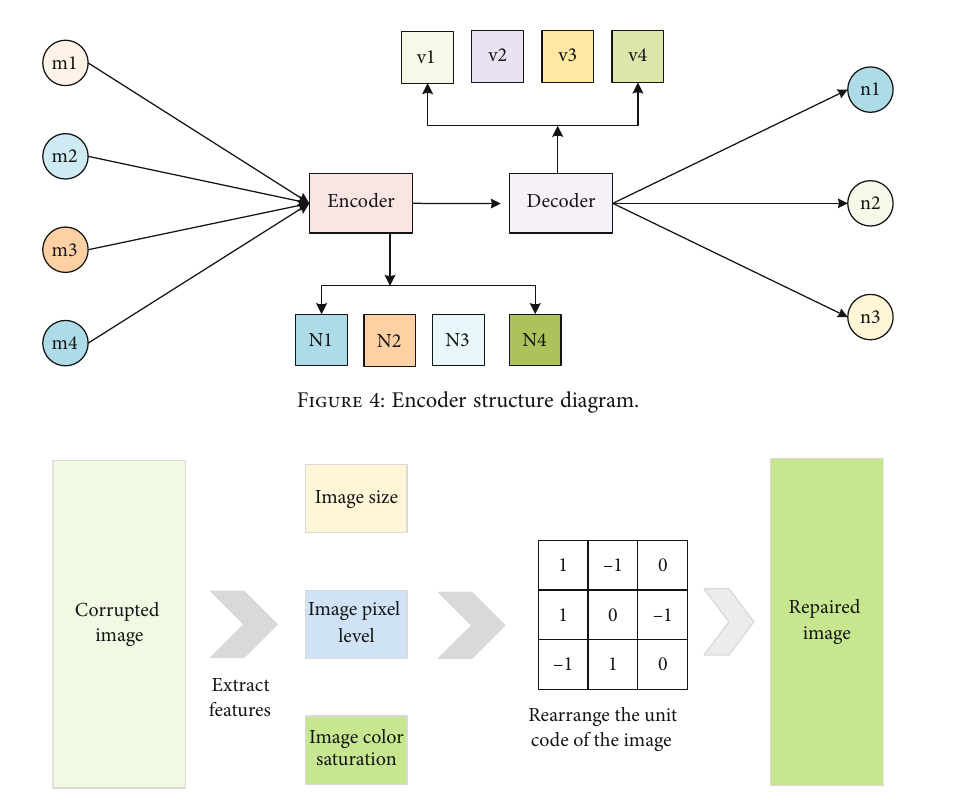
Figure 5: Flow chart of the